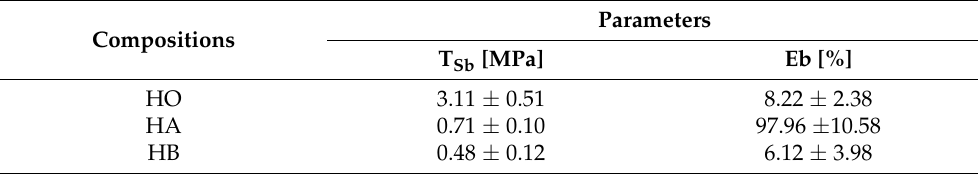
Table 2. Results of mechanical measurements.